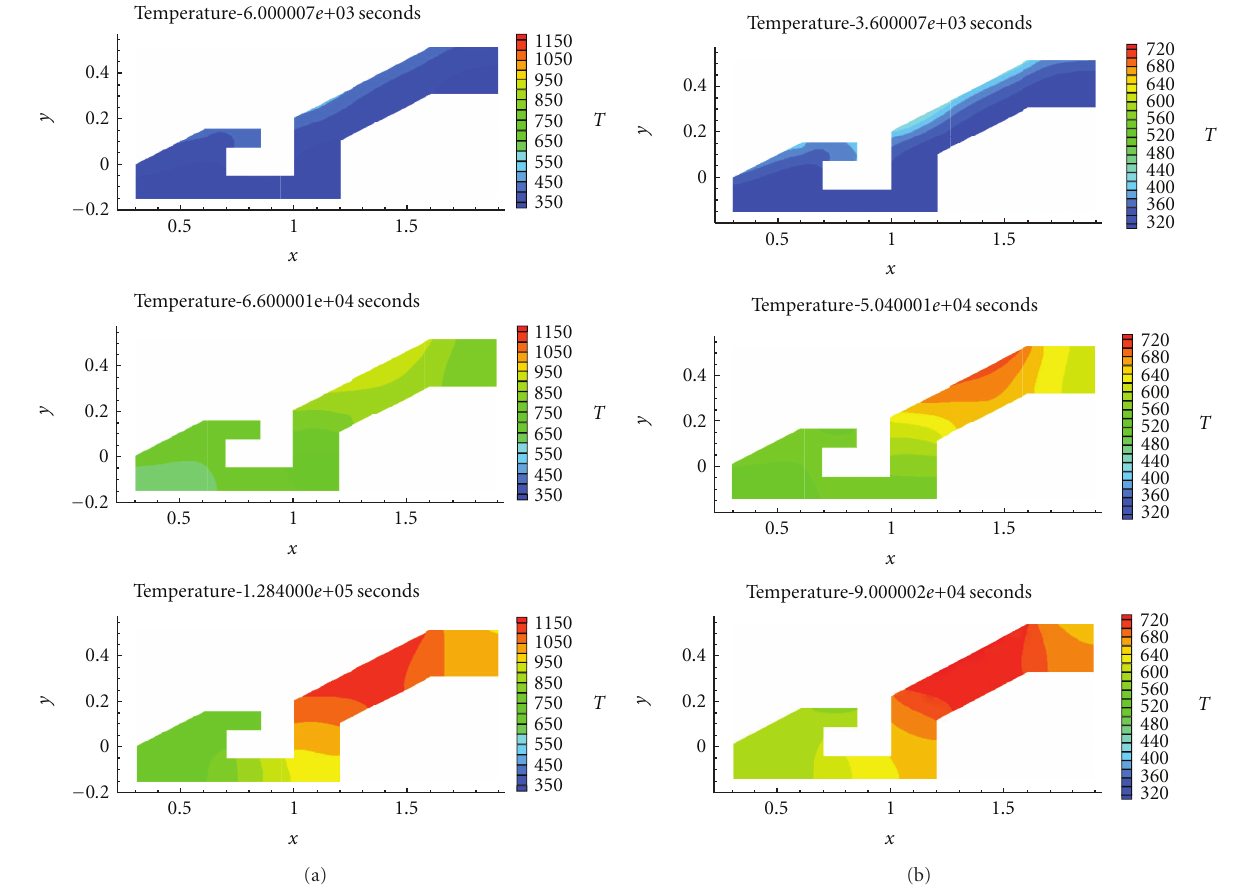
Figure 8: Evolution of the temperature within the flap without (a) and with (b) radiation e ff ects.